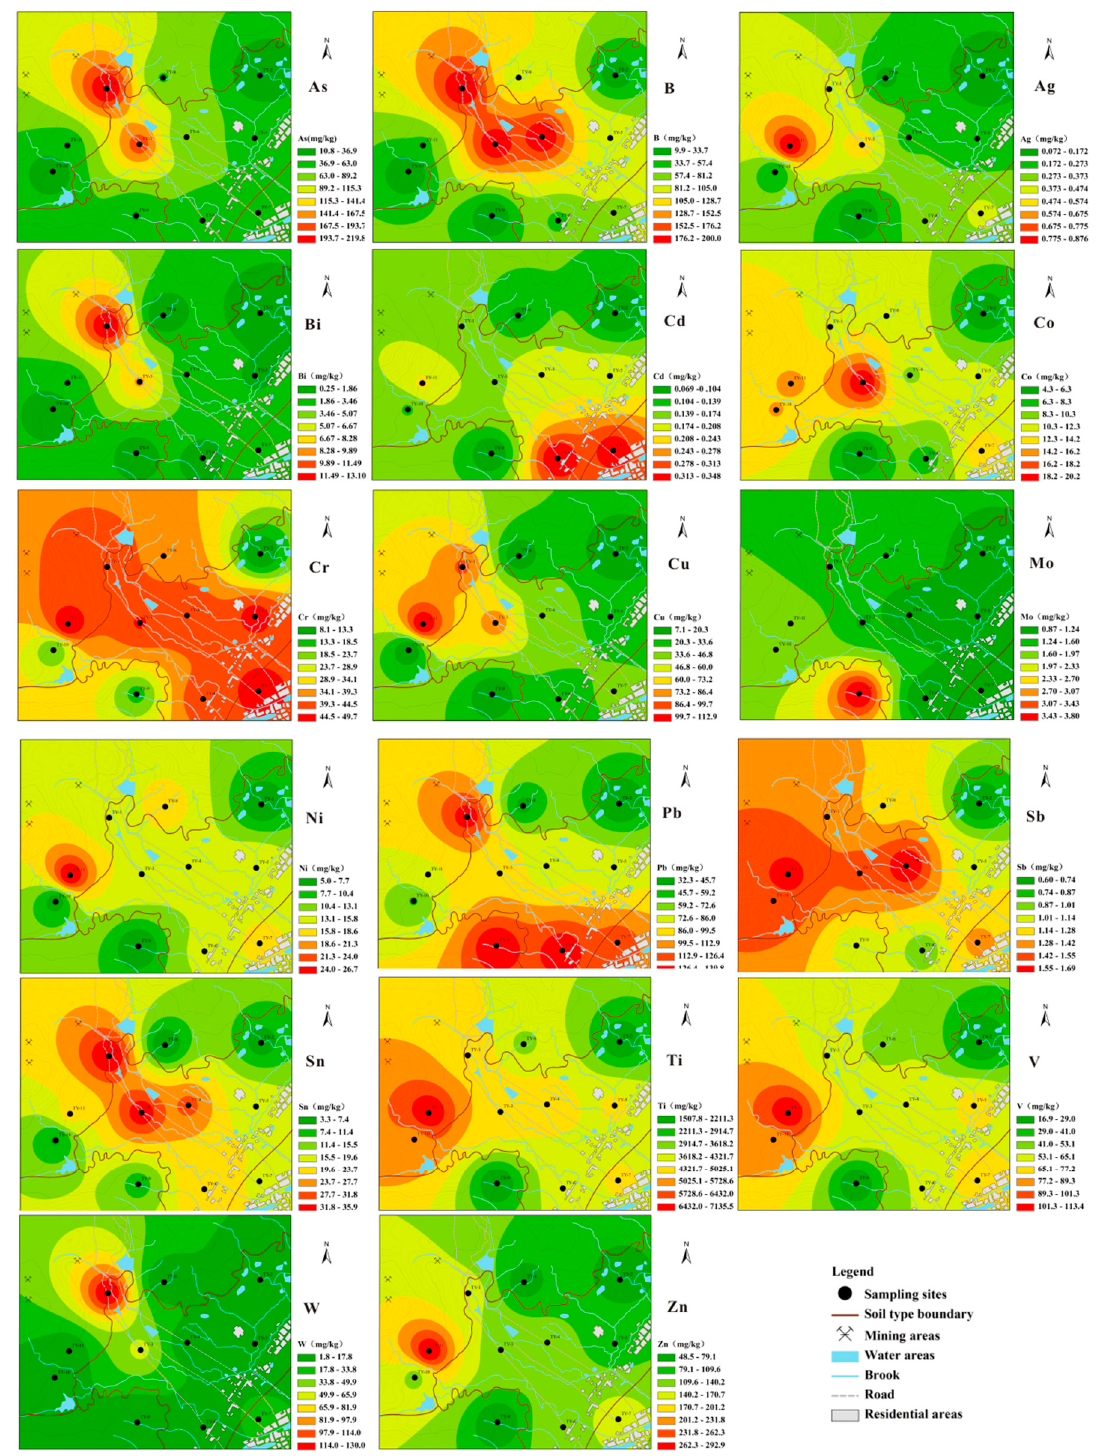
Figure 3. Spatial distribution of metals in the surface soils of the studied area.